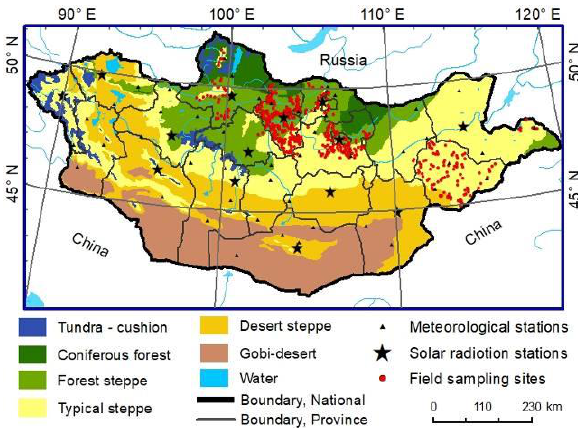
Figure 1. Study area and the distribution of vegetation types, meteorological stations and field sampling